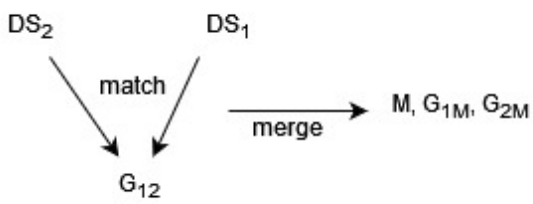
Figure 4. Common task in data integration with two sources.